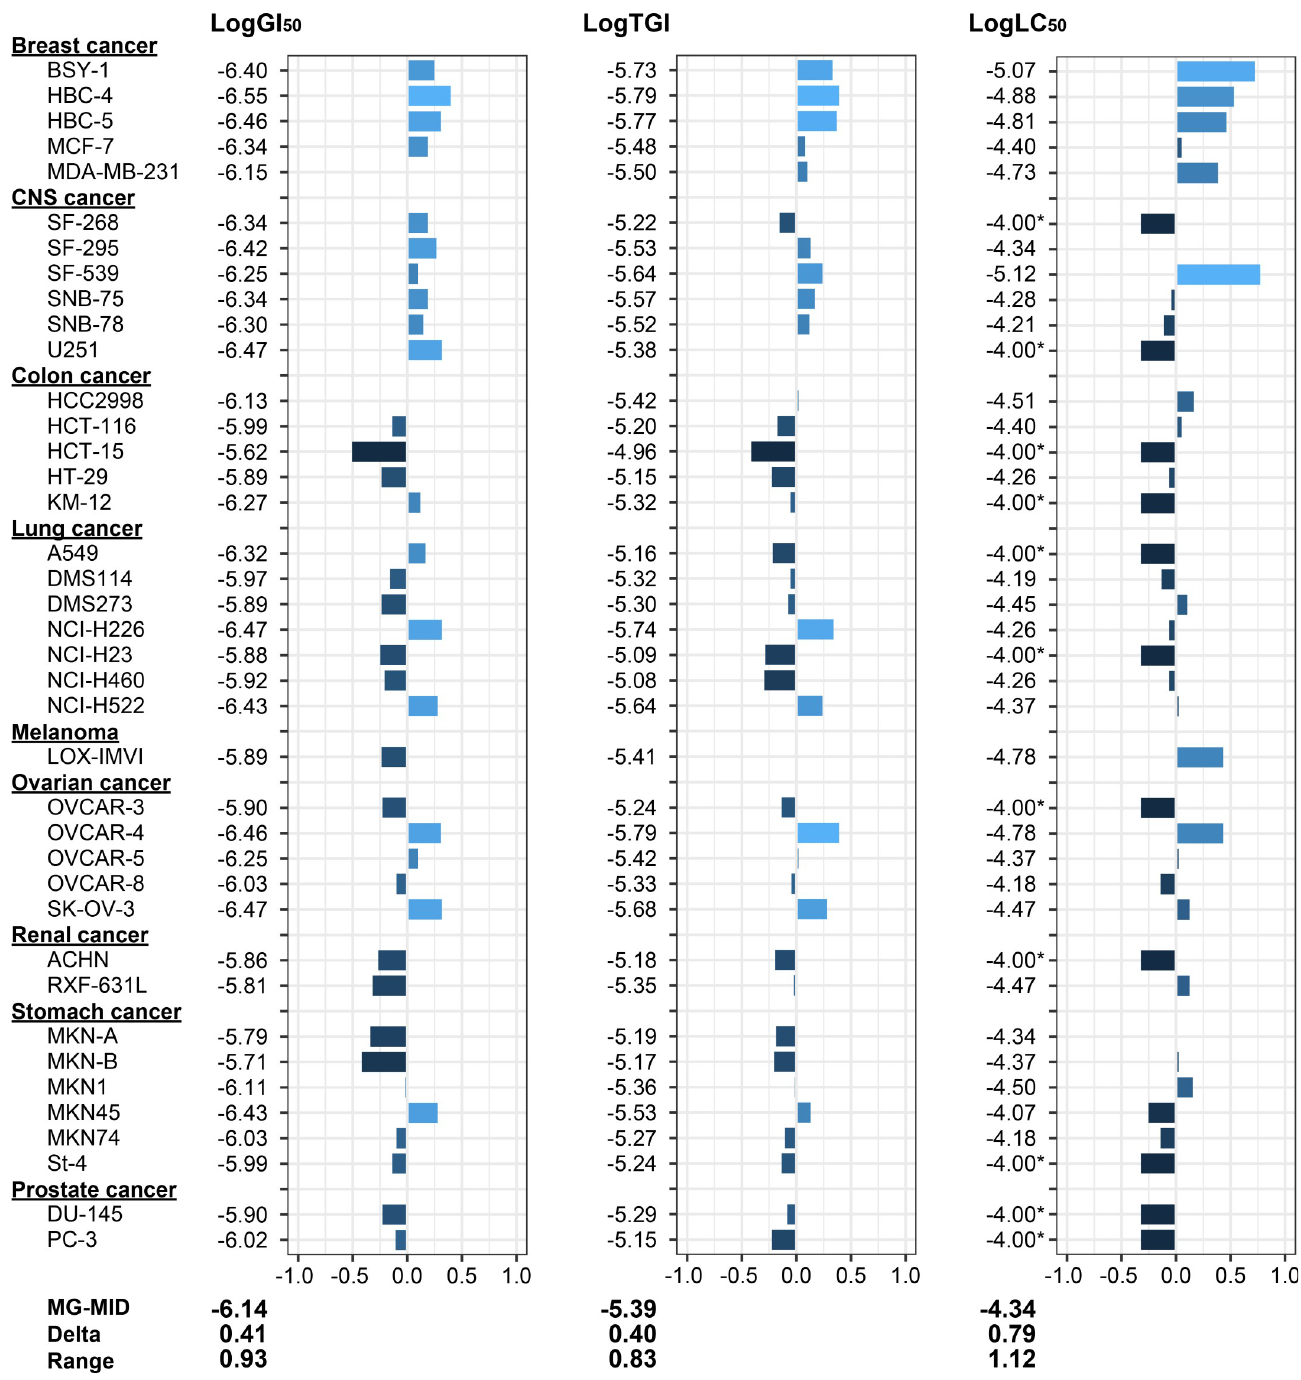
Fig 3. Mean graphs showing the relative sensitivity of each cell line against diaphorin. The logarithms of GI 50, TGI, and LC 50 are indicated for each cell line. The x-axis represents the difference between the mean of the parameters for all 39 cell lines and the parameters for each cell line. Namely, columns extending to the right of center (mean) indicate that the corresponding cell lines are more sensitive to diaphorin than the average of the 39 cell lines, and columns extending to the left indicate that the cell lines are more resistant to diaphorin than the average. MG-MID: the mean of log GI 50, TGI, or LC 50 for the 39 cell lines. Delta: the difference between the MG-MID and the log GI 50, TGI, or LC 50 of the most sensitive cell line. Range: the difference between the log GI 50, TGI, or LC 50 of the most resistant cell line and those of the most sensitive one. Asterisks ( � ) indicate that the log LC 50 values were greater than -4.00 (10 − 4 M), the maximum concentration of diaphorin tested, at which the treatment did not result in 50% reduction of the cells at the end of the treatment as compared with those at the beginning.